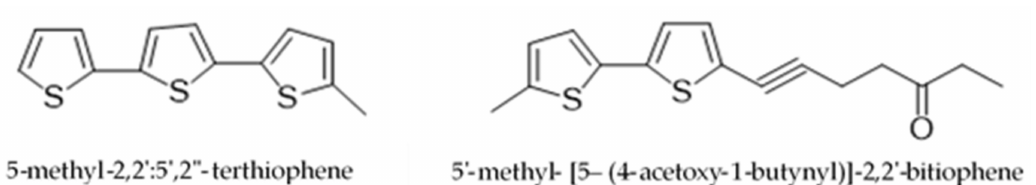
Figure 4. Components isolated from P. ruderale with antileishmanial